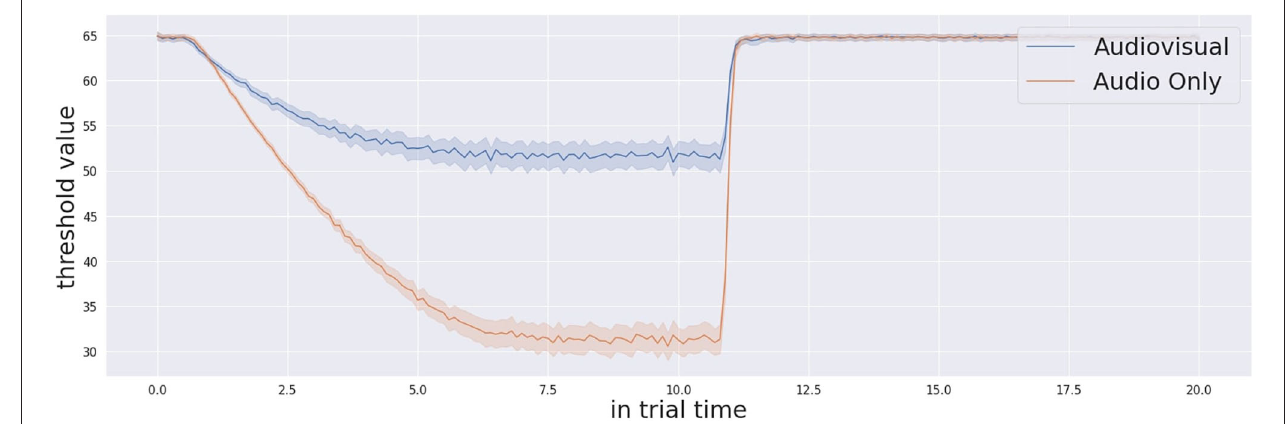
FIGURE 4 | Confidence threshold profile across the whole trial time (20 s) for both audio-visual and audio only